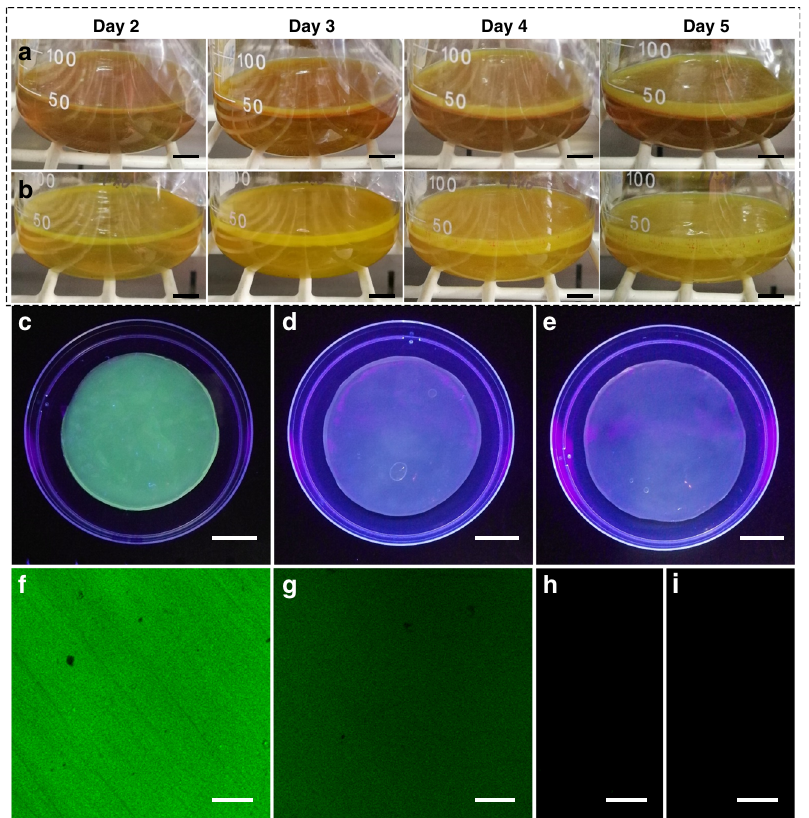
Fig. 2 Biological incorporation of fl uorescent-tagged glucose (6CF-Glc) into BC fi bers. a, b Images of 6CF-BC fermentation under standard conditions (30 °C) on days 2, 3, 4, and 5. The thickness of a HC-6CF-BC (high concentration of 6CF-Glc, 0.95 mg mL − 1 ) was thinner than b LC-6CF-BC (low concentration of 6CF-Glc, 0.38 mg mL − 1 ). The scale bar corresponds to 1 cm. c – e Images of 6CF-BC, BC, and Im-6CF/BC observed under UV light (365 nm). c 6CF-BC showed green fl uorescence, whereas d Im-6CF/BC and e BC showed no fl uorescence. The scale bar corresponds to 2 cm. f – i Images of 6CF-BC, BC, and Im-6CF/BC observed with CLSM (excitation wavelength 488 nm). f HC-6CF-BC and g LC-6CF-BC showed green fl uorescence, whereas h Im-6CF/BC and i BC showed no fl uorescence. The scale bar corresponds to 100 μ